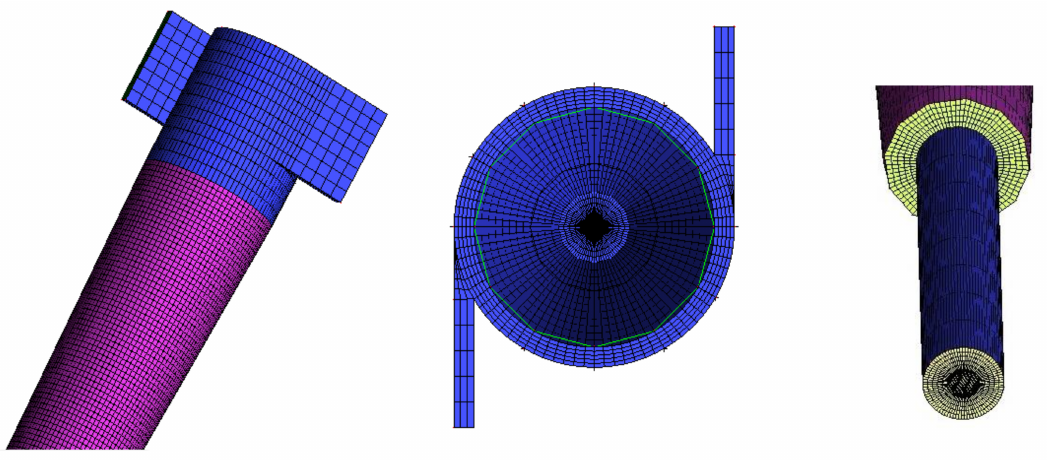
Figure 2. Representation of the numerical mesh of the study